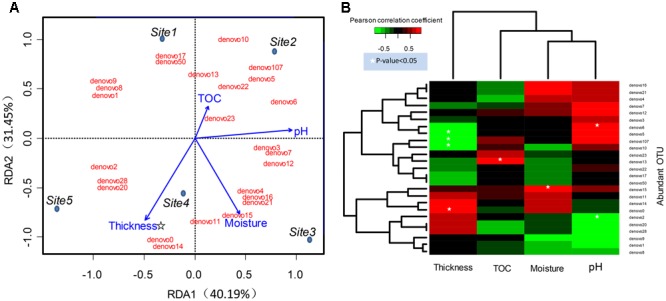
Relations between abundant OTUs and environmental factors. (A) Ordination diagram of the RDA of abundant bacteria OTU profile in the glacial foreland. Blue dots indicate the study sites. Sites 1 and 2 were ice-free, and Sites 3, 4, and 5 were ice-covered. Red text indicates the abundant bacteria OTUs. Blue arrows indicate the environmental variables. The star indicates that the p-value < 0.05 (Monte Carlo permutation test, Supplementary Table S3). (B) The environmental factors associated with abundant bacteria OTUs in the glacial foreland soil. The Pearson correlation coefficient indicates the correlation between OTU sequence abundance and an environmental factor. A white star indicates that the p-value of the correlation is <0.05.